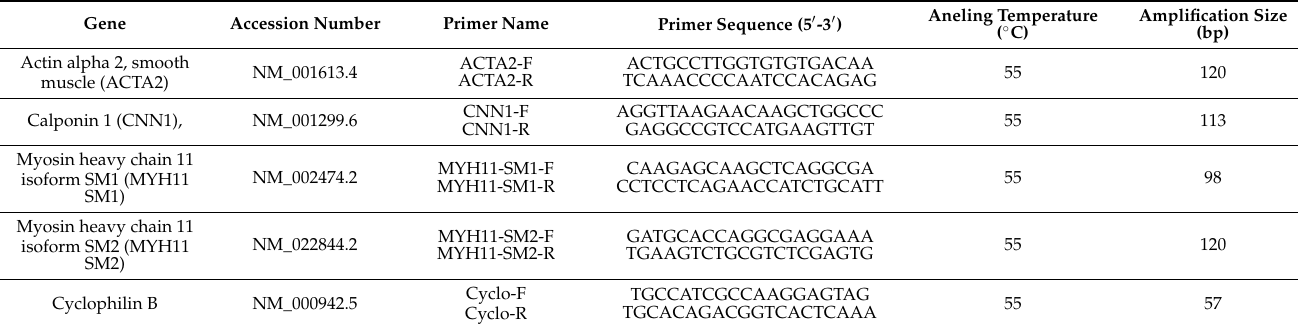
Table 1. Primer list and sequences for